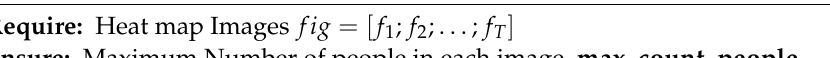
Algorithm 2 Connected component algorithm.